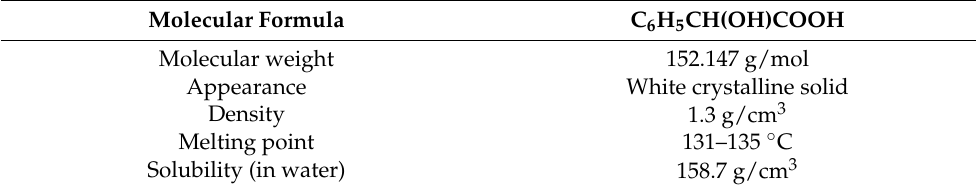
Table 4. Properties of mandelic